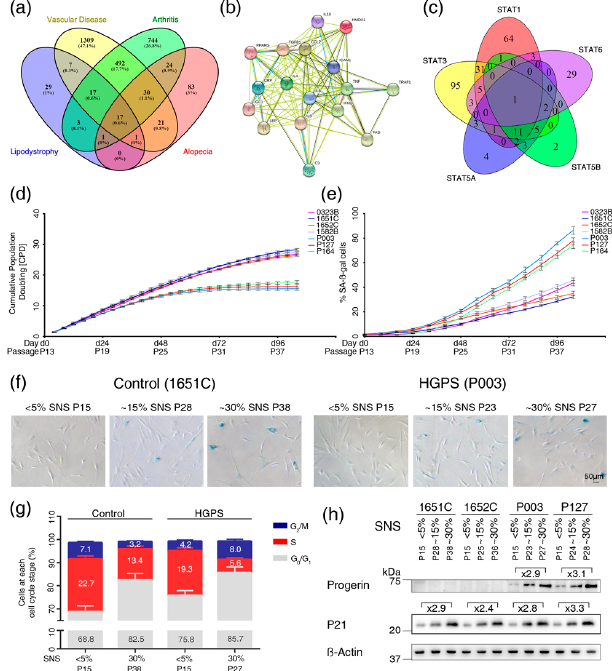
Figure 1. Text mining analysis to identify genes associated with vascular disease, arthritis, alopecia and lipodystrophy, and characterization of the cell-based aging model. ( a ) Venn diagram of the 2778 genes linked to the four diseases as determined by text mining. ( b ) Interaction network of the 17 gene products visualized by STRING. Nodes are proteins, and lines represent functional associations between proteins. A green line indicates neighborhood evidence; a blue line indicates cooccurrence evidence; a purple line indicates experimental evidence; a light blue line indicates database evidence; a black line indicates coexpression evidence. ( c ) Venn diagram of the signal transducer and activator of transcription (STAT) gene family showing the number of genes that are regulated by di ff erent STATs as indicated by the corresponding circles. Each gene was searched in the TRRUST version 2 (https: // www.grnpedia.org / trrust / ), TfactS (http: // www.tfacts.org / ) and Regulatory Circuits databases (http: // regulatorycircuits.org / ). Altogether, a total of 269 genes were found and curated to prevent repetitions due to aliases. ( d ) Growth curves of four independent control cell strains (purple, blue, orange, gray) and three Hutchinson-Gilford progeria syndrome (HGPS) cell strains (light blue, red, and turquoise). All cultures started at passage 13, and at this passage, the percentage of SA-ß-gal-positive cells was less than 5% in all cell strains. Proliferation rates were determined over 26 passages over 104 days. ( e ) The percentage of SA-ß-gal-positive cells was scored every other passage in cultures from panel d. ( f ) Representative images of SA-ß-gal-positive cells in cultures exhibiting < 5% SNS, 15% SNS and 30% SNS. GMO1651c corresponds to normal fibroblasts and P003 corresponds to HGADFN003, an HGPS cell strain. ( g ) Relative percentage of cells in the G 0 / G 1 , S and G 2 / M phases of the cell cycle are shown for normal (1651c) and HGPS (P003) cultures with a senescence index of < 5% and 30%. PI was used for DNA staining. ( h ) Representative western blot of control (1651c, 1652c) and HGPS (P003, P127) fibroblasts from cultures at the indicated percentages of senescence. Antibodies directed against the indicated proteins were used. All experiments were performed at least three times ( n >